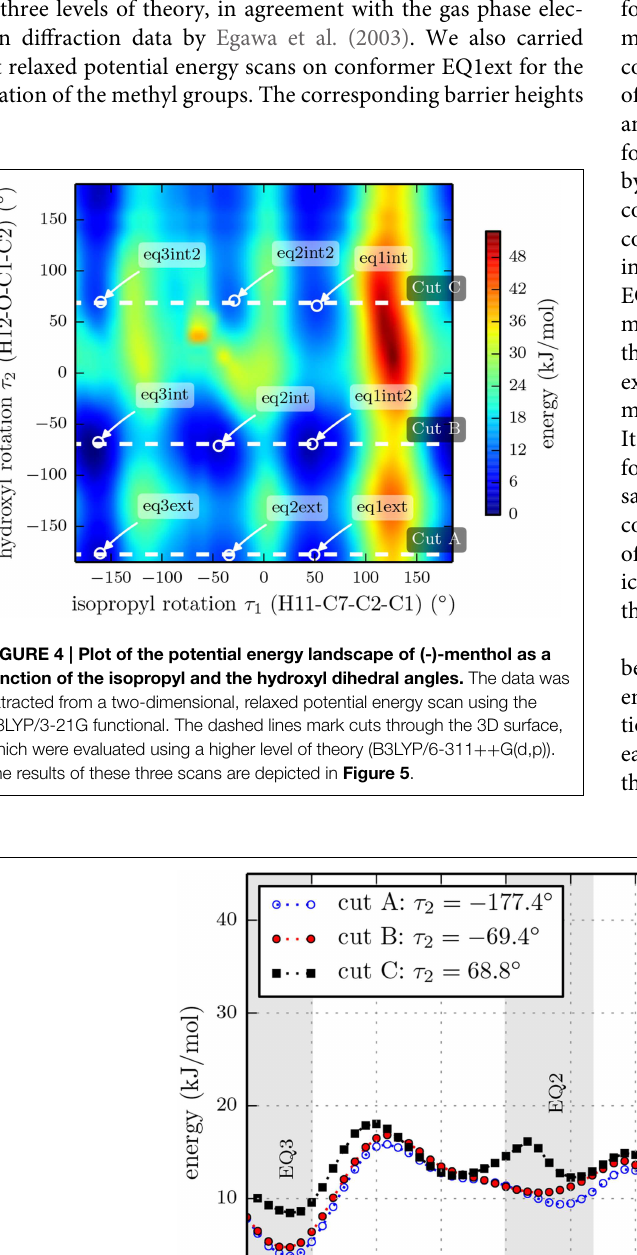
B3LYP/6-311 ++ G(d,p) level of theory. All three traces have the same overall features, while cut A contains the lowest minima. The double minimum structure of cut C around EQ2 might be an artifact due to fixing dihedral angle τ 2 .